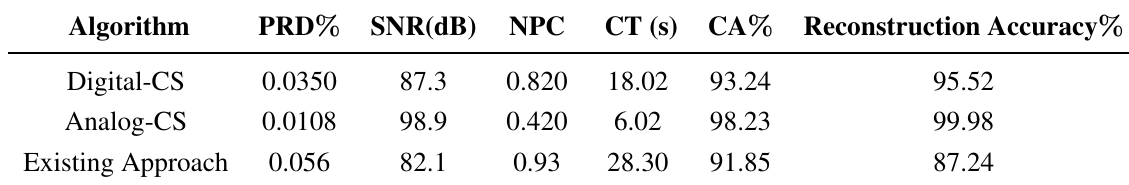
Table 9. Comparison on healthy sEMG signals.